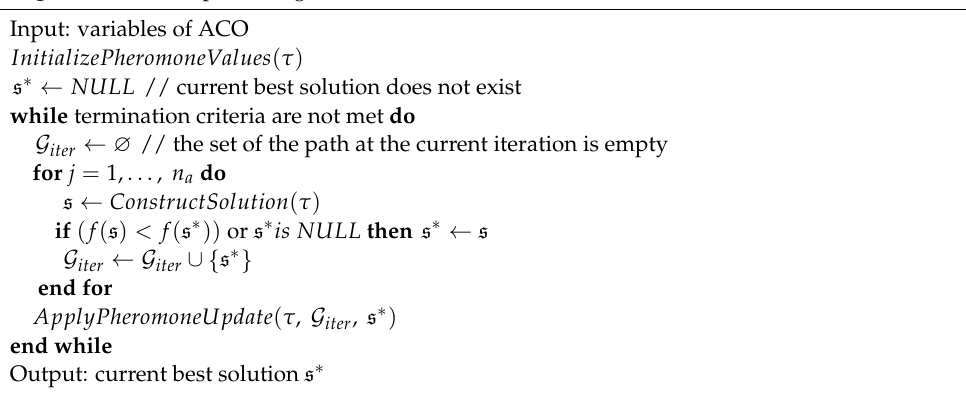
Algorithm 1: ACO